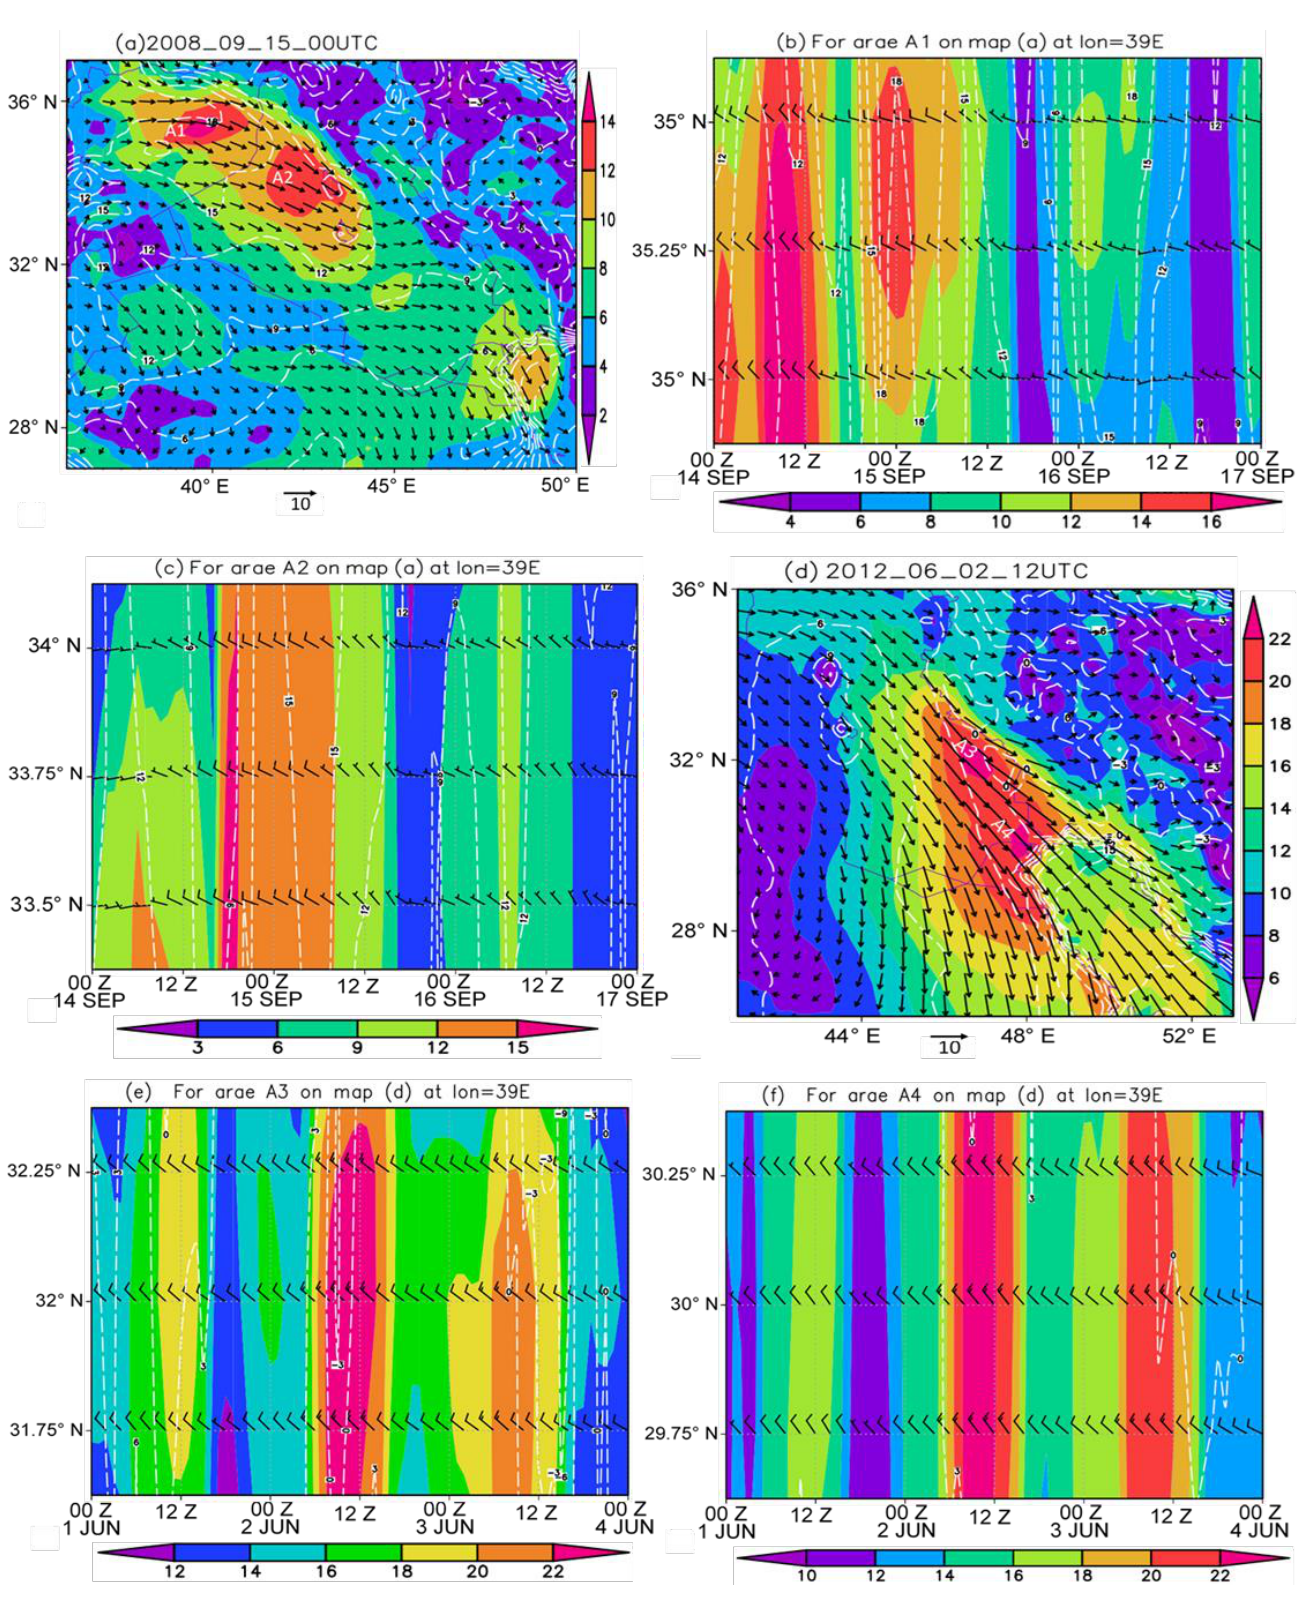
Figure 6. The figure shows 10 m of wind gust (ms − 1 ) (shaded), 10 m of wind vector (ms − 1 ) on ( a ) 15 September 2008 and ( d ) 2 June 2012, and 2 m dew point temperature ( ◦ C) (white color dash contour) at times indicated and time series of ( b ) A1, ( c ) A2, ( e ) A3, and ( f ) A4 areas.